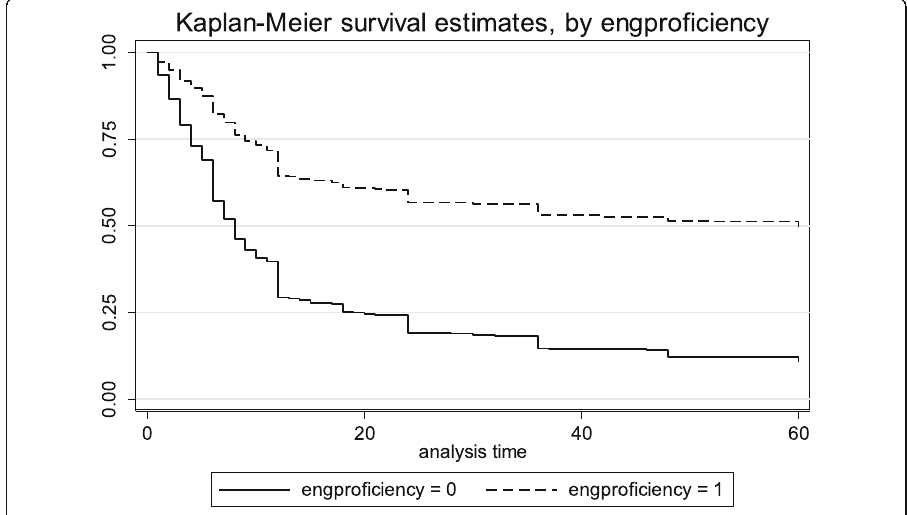
Fig. 3 Kaplan-Meier survival estimate for last migration sample. Strata English proficiency (ESL). The horizontal axis displays the number of months of trips for the first and last migrations, respectively. The vertical axis displays the Kaplan-Meier survival